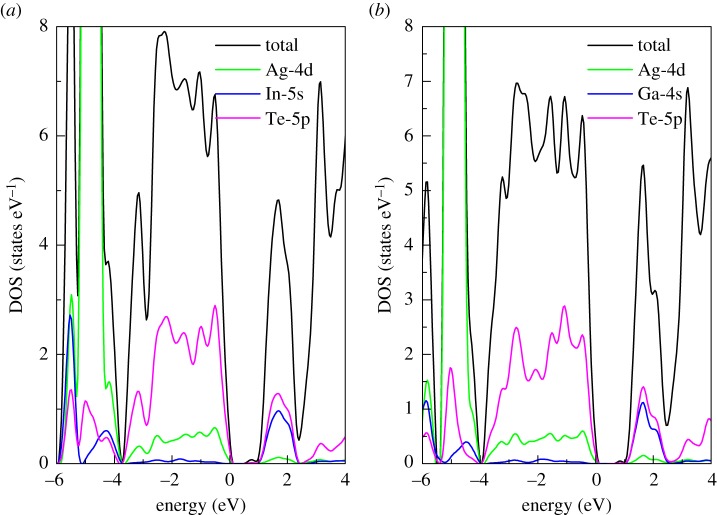
Calculated partial and total DOS for (a) AgInTe2 and (b) AgGaTe2 (Fermi level is set at 0 eV).